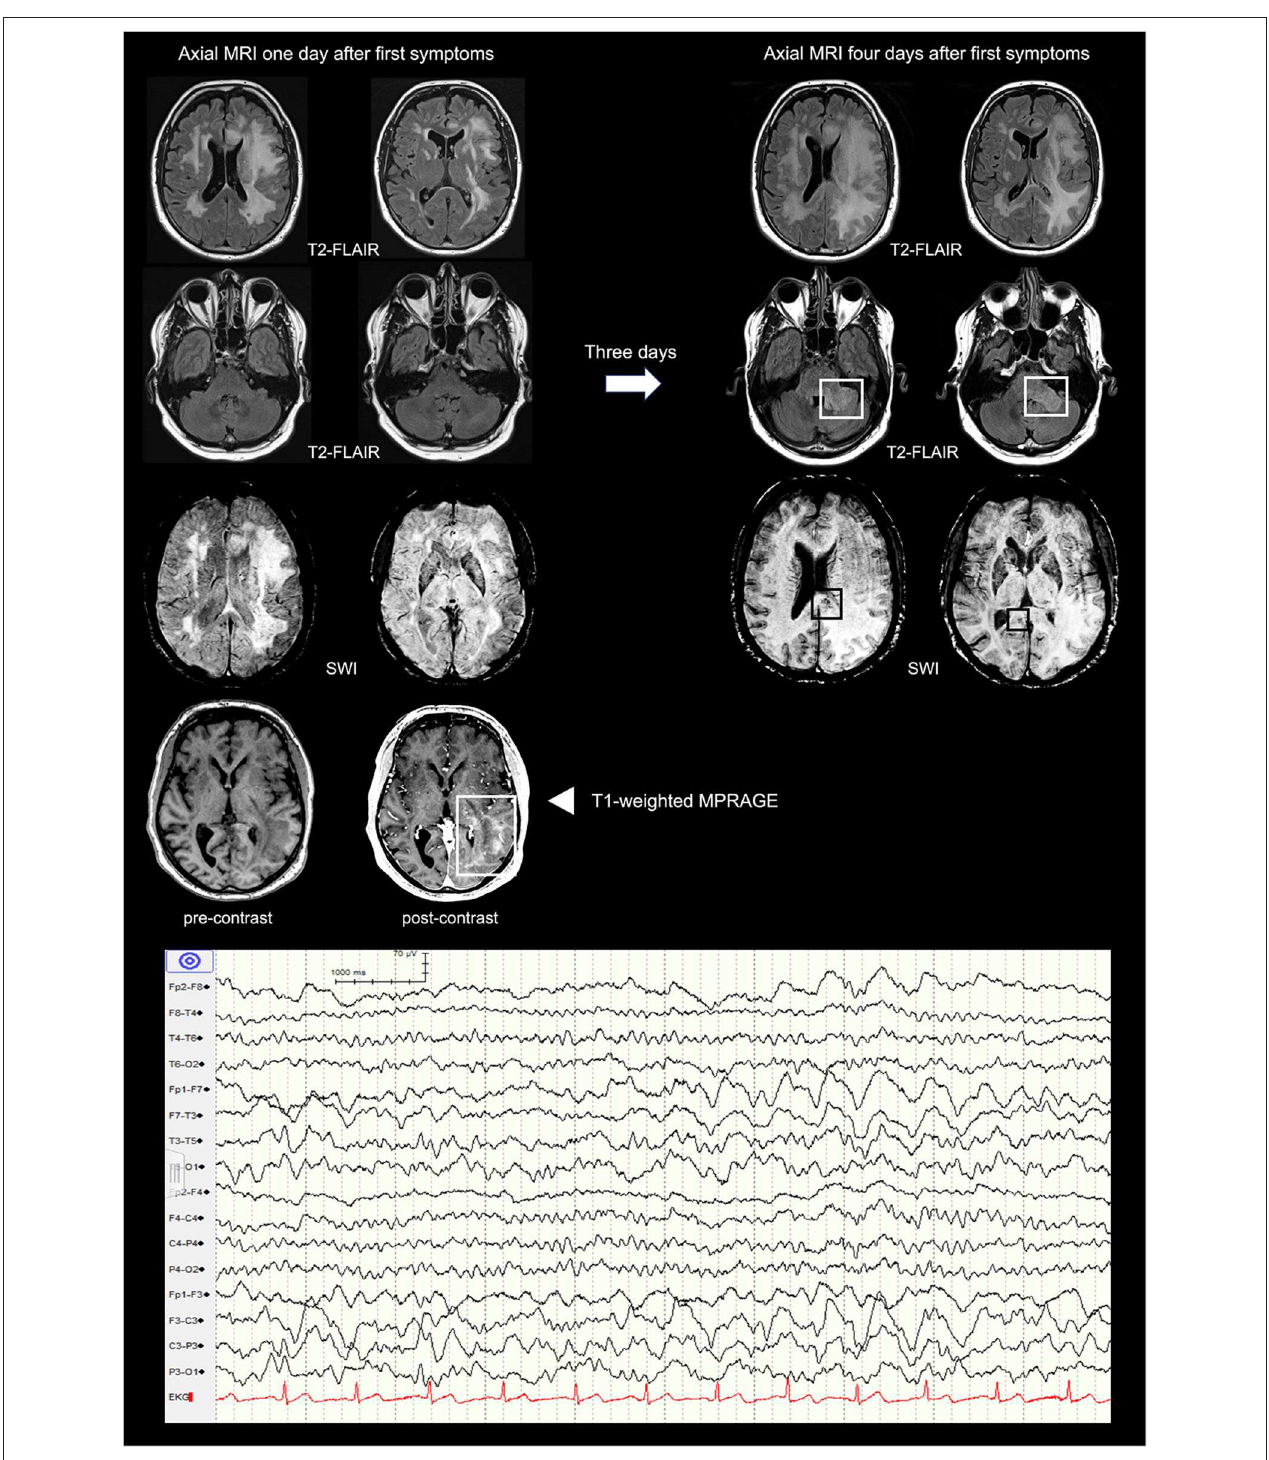
FIGURE 2 | Cerebral MRI presenting the temporal evolution within 3 days (from left to right) and EEG excerpt. First row: axial T2-weighted FLAIR images showing increasing bilateral confluent widespread hyperintensities of the supratentorial white matter predominantly on the left. Second row: axial T2-weighted FLAIR images revealing new hyperintensities of the left cerebellar peduncle. Third row: axial SWI demonstrating subtle and small susceptibility artifacts in the splenium of the corpus callosum. Fourth row: axial pre- and post-contrast T1-weighted MPRAGE showing enhancement of the left parieto-occipital region. FLAIR, Fluid-Attenuated Inversion Recovery; SWI, Susceptibility Weighted Imaging; MPRAGE, Magnetization-Prepared Rapid Acquisition with Gradient Echo.